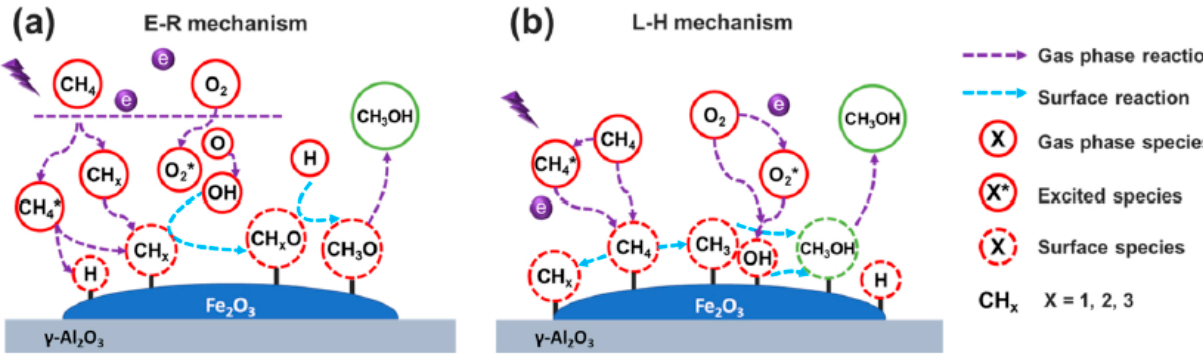
Figure 22. Proposed mechanisms in plasma-catalytic DOMTM on a Fe/ γ -Al 2 O 3 surface [118]. Copyright 2021 Elsevier.